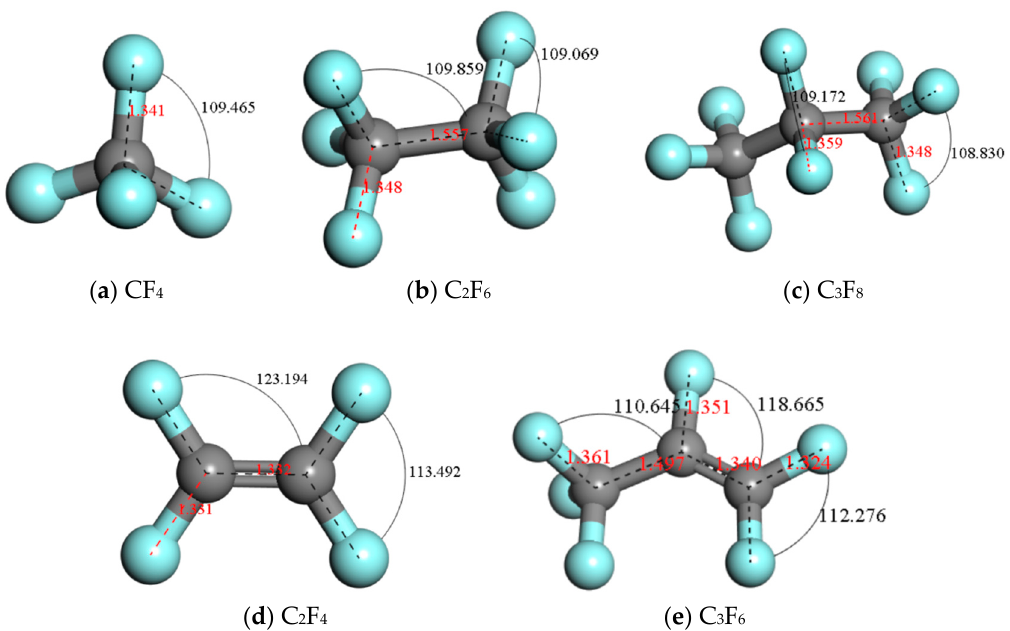
Figure 10. Molecular model of decomposition products and structural parameters. Table 4. Decomposition products and energy change.